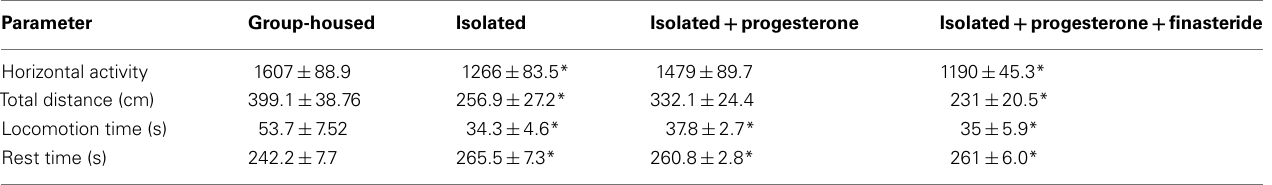
Table 1 | Changes in spontaneous locomotor activity in SI mice: effect of treatment with progesterone and co-treatment with progesterone and